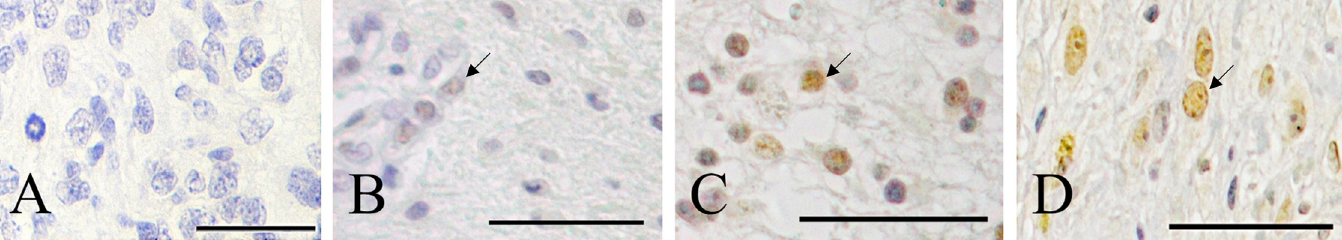
Fig 2. Immunohistochemical staining of HCMV in gliomas. (A)Negative GBM. (B) Positive GBM, score 4. (C) Positive AST II, score 8. (D) Positive control (HCMV infected colon). Arrows indicate HCMV nuclear protein expression in neoplastic cells (brown). All samples were counterstained with Eosin. Scale bar 10 μ m.